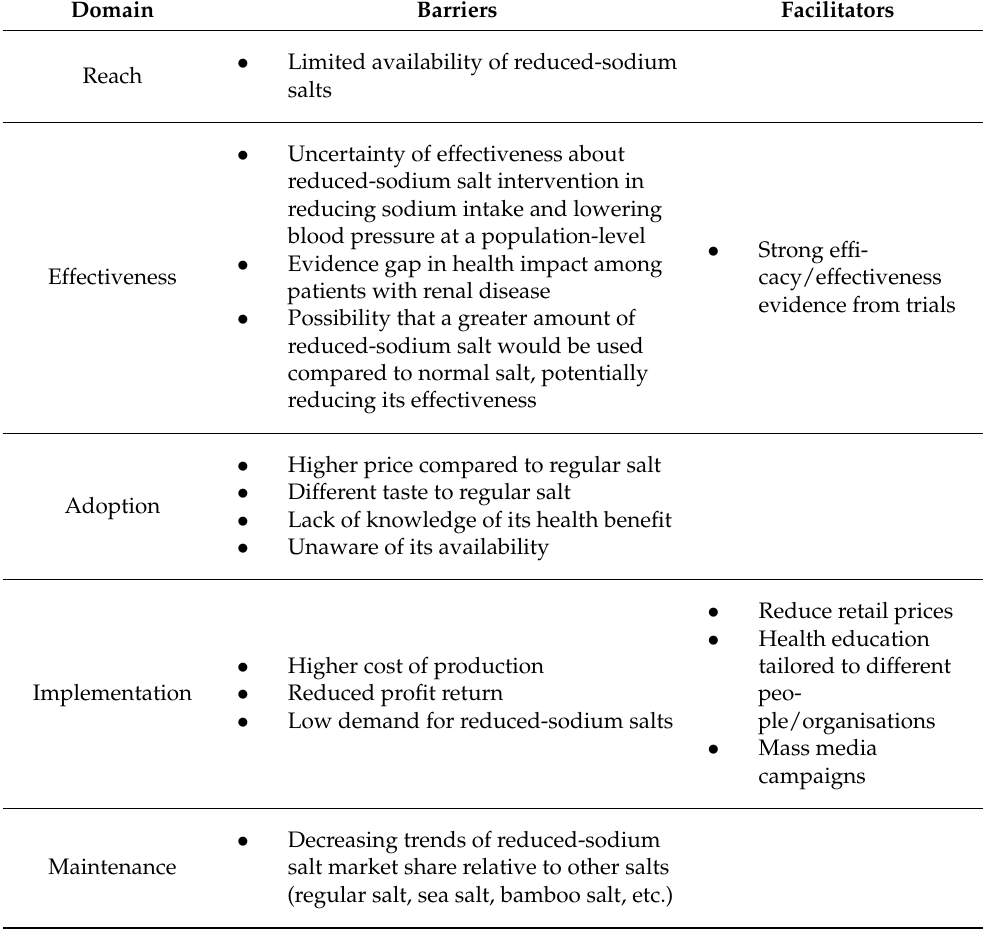
Table 3. Themes under RE-AIM domains by facilitators and